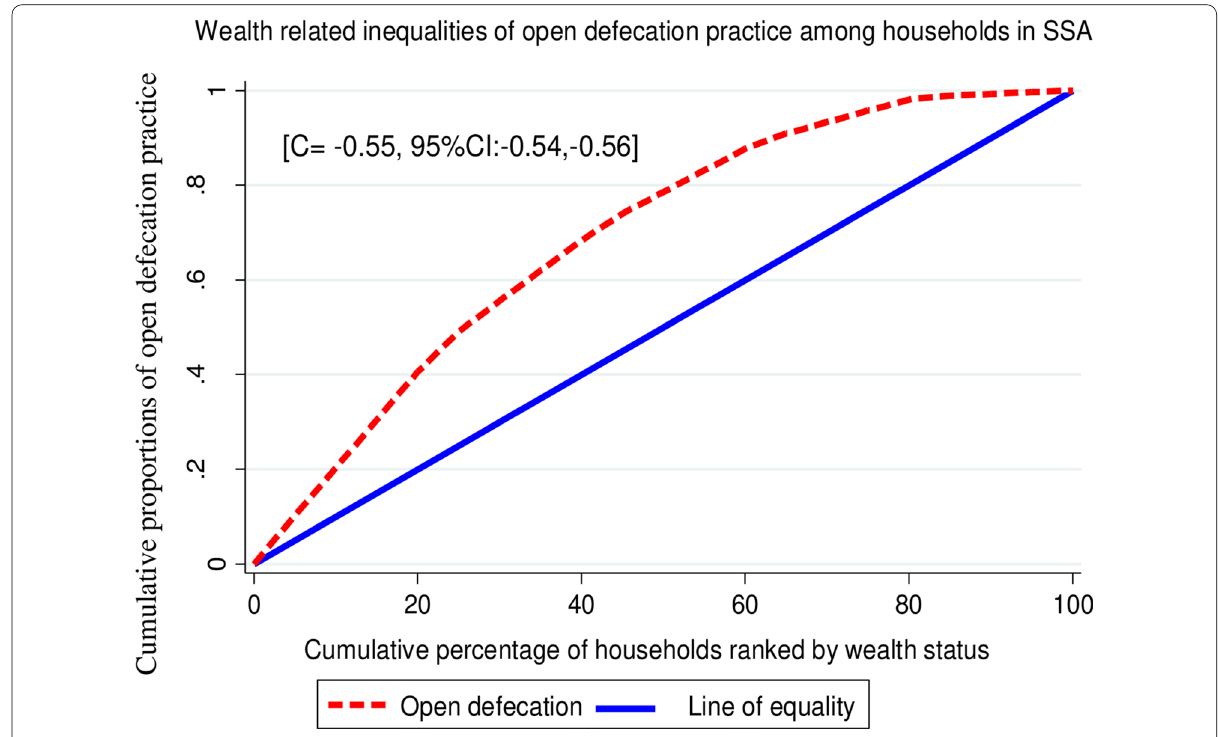
Fig. 2 Wealth-related inequality of open defecation practice 33 sub-Saharan African